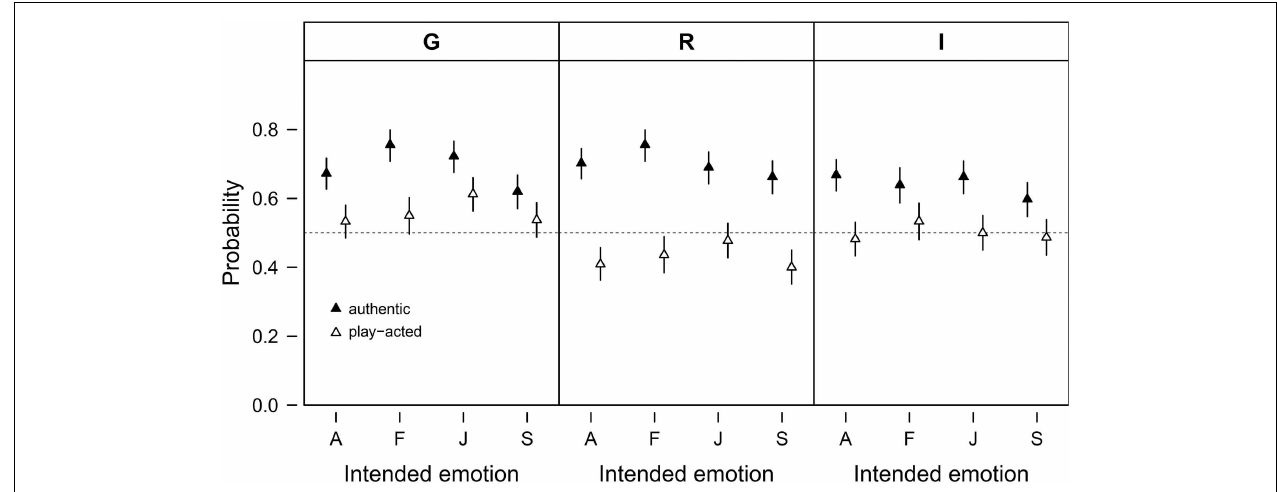
affiliation (G – Germany, R – Romania, I – Indonesia). Given are means and 95% confidence intervals.The probability of correct authenticity recognition by chance is 0.5 as indicated by the dashed horizontal lines.